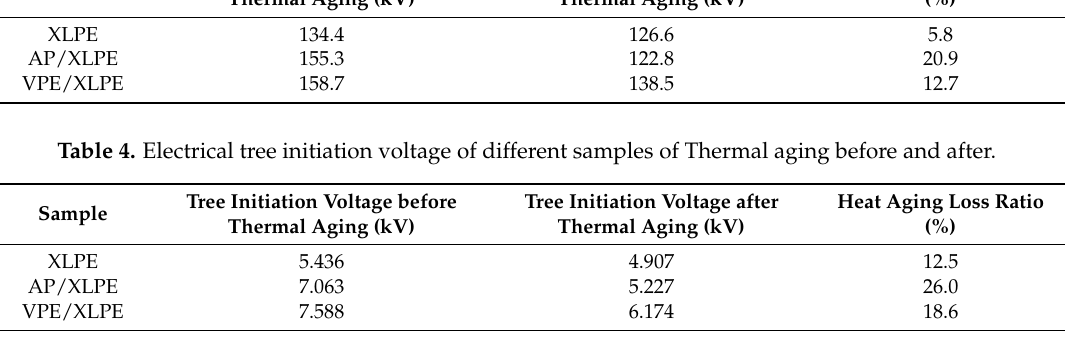
Table 3. AC breakdown strength of different samples of Thermal aging before and after. Sample